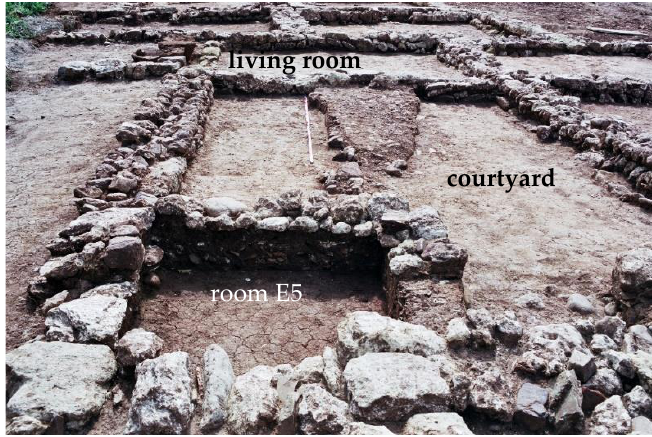
Figure 14. House 101. Room E5 in the courtyard.